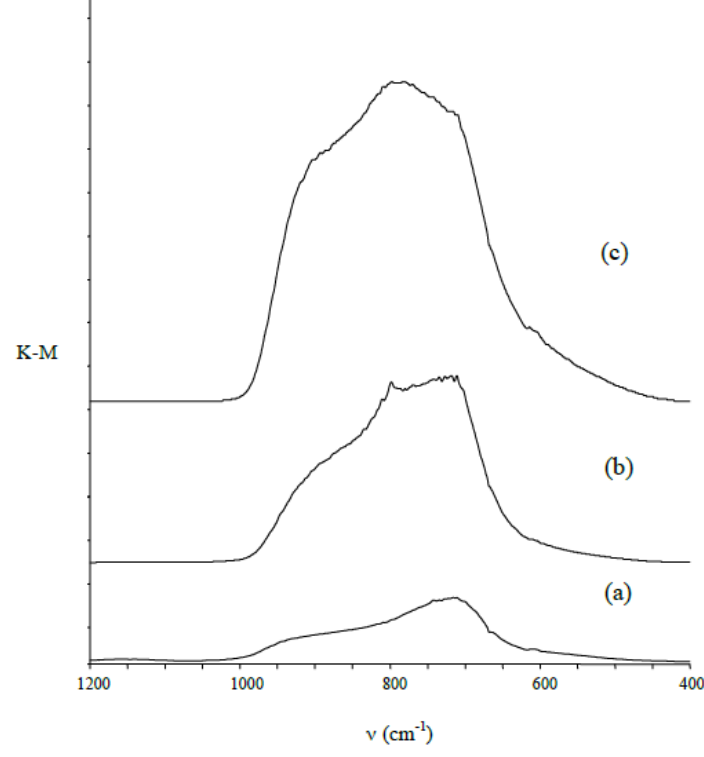
Figure 6. Diffuse reflectance infrared Fourier transform spectroscopy (DRIFT) spectra of the produced titania materials: ( a ) PTN; ( b ) TNTE03; ( c ) TNTE2.